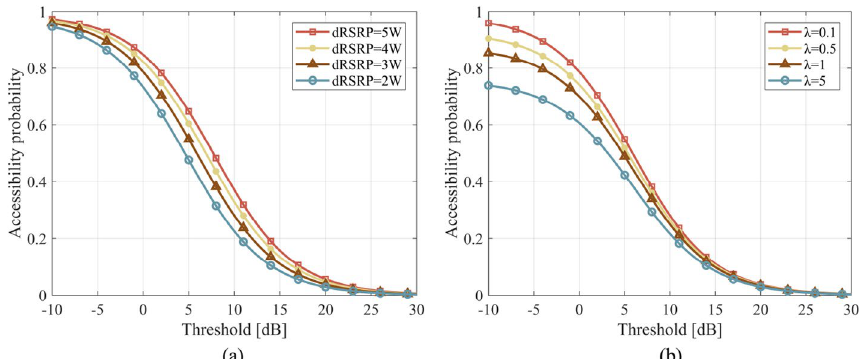
Fig. 4 Accessibility probability versus the threshold for: a dRSRP and b λ. Figure depicts the relationship of accessibility probability with threshold. a shows the change of their relationship in different conditions; red, yellow, brown and blue lines are the cases where downlink reference signal received power is equal to 5 W, 4 W, 3 W and 2 W, respectively. b shows the cases of uplink reference signal received power impact factor is equal to 0.1, 0.5, 1 and 5